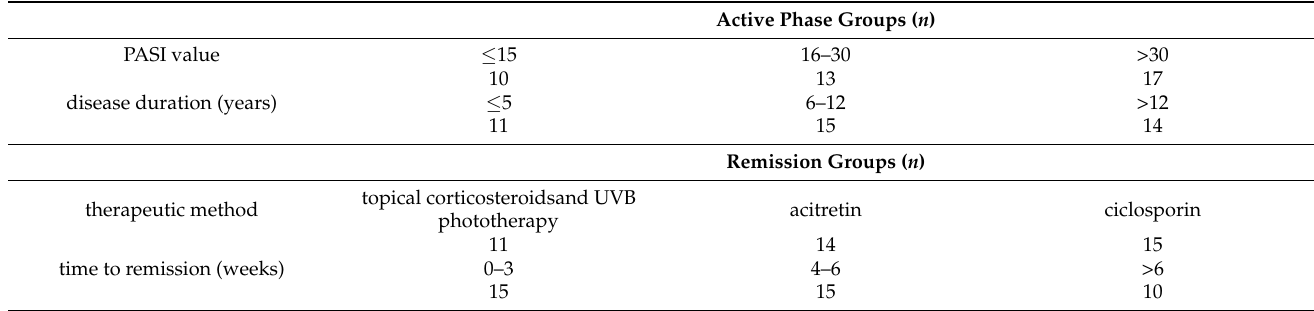
Table 1. Clinical characteristics of